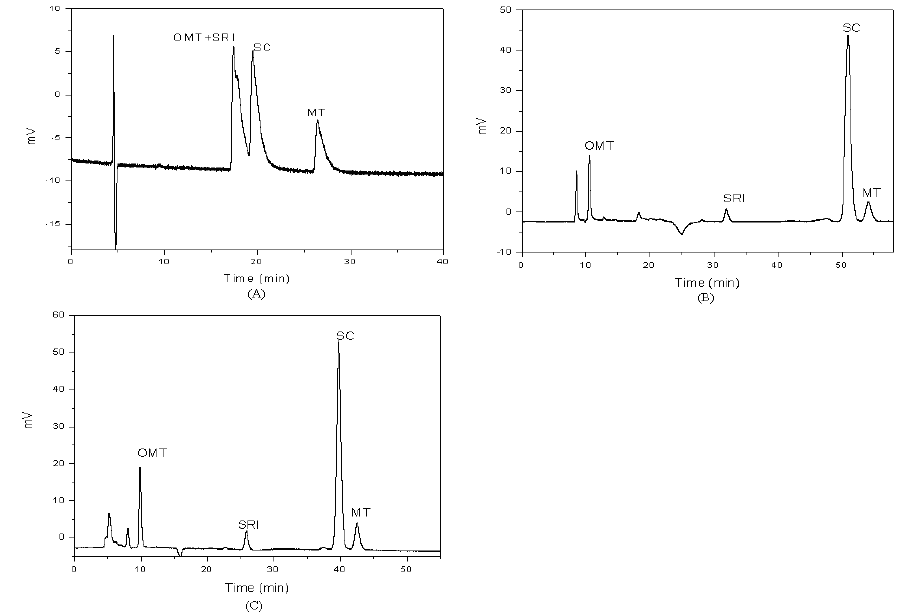
Figure 2. The chromatograms of standard compounds of OMT, SRI, SC and MT in methonal/water (45/55, v/v) as the mobile phase without modifier (A), with diethylamine (B) and with diethylamine and IL